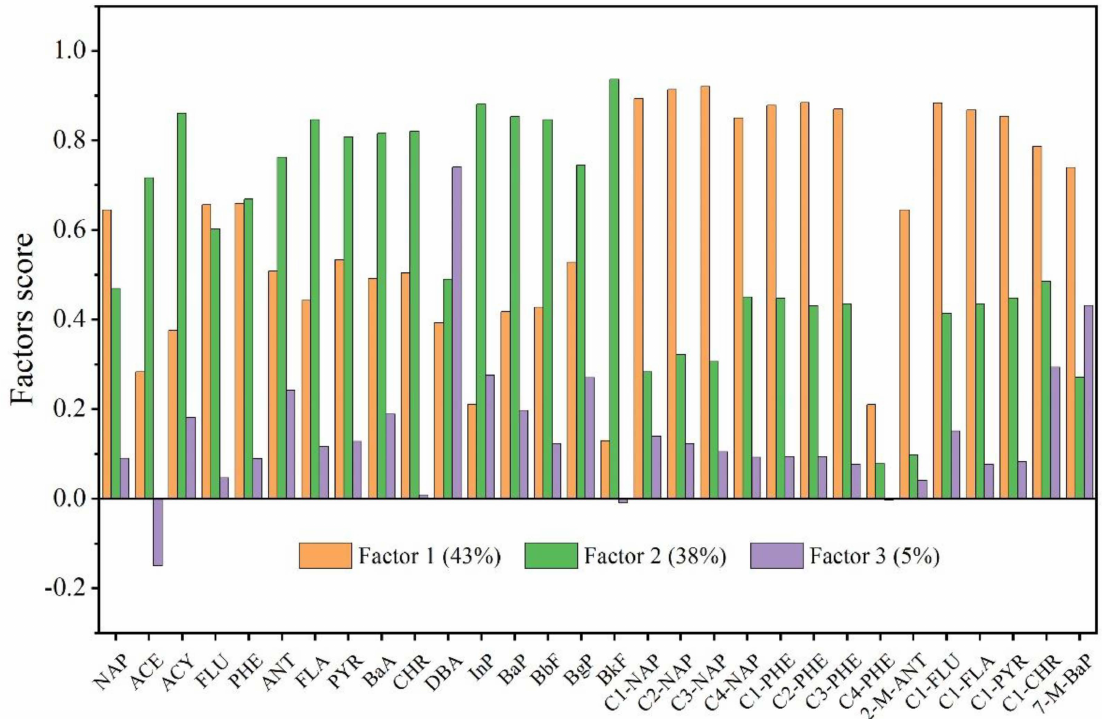
Figure 5. Factor score of principal component